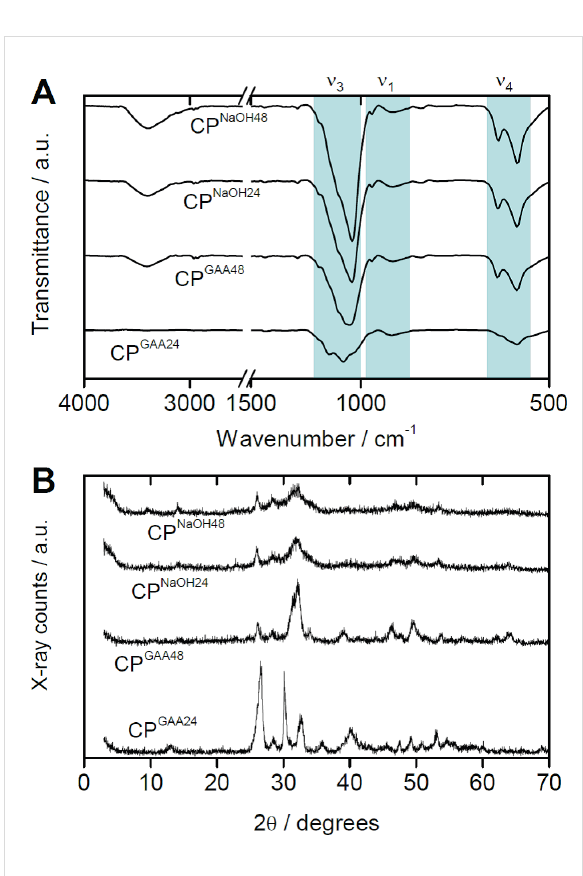
Figure 1: (A) ATR-FTIR spectra and (B) XRD patterns of calcium phosphates obtained from [Bmim][Cl]. The reflection at 14.2 degrees 2 θ is from the sample holder